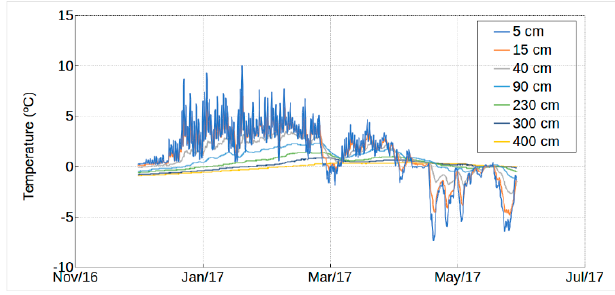
Figure 12. Ground temperatures at different depths from the Papagal borehole in Hurd Peninsula (Livingston Island).